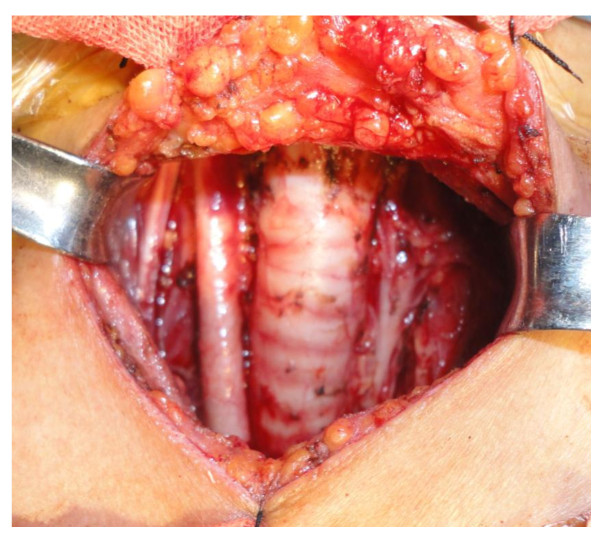
Total thyroidectomy conbined with level III-IV and VI dissection.